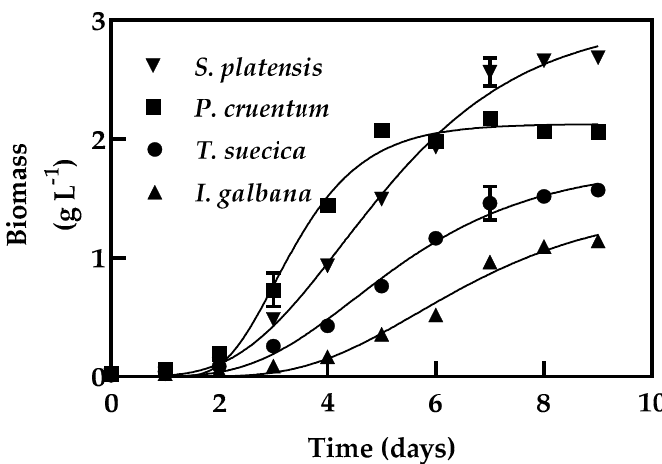
Figure 1. Growth of microalgae in batch cultures. Microalgae were cultivated in batch operation mode in a photobioreactor at 200 rpm, at 30 ◦ C, 39.63 kJ d − 1 of light supplied, and 1 L working volume. in a photobioreactor at 200 rpm, at 30 °C, 39.63 kJ d − 1 of light supplied, and 1 L working volume. Each Each point is the mean of 3 point is the mean of 3 replicates.